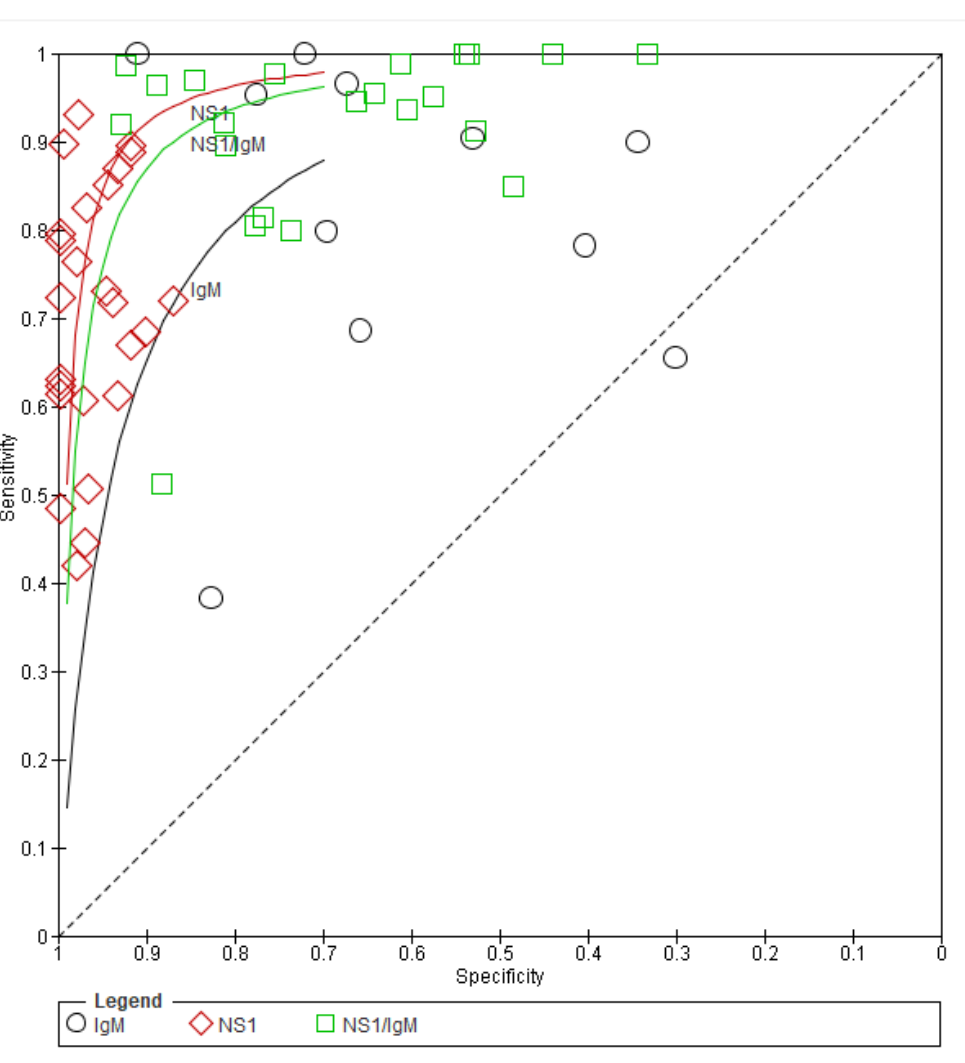
Figure 5. Summary ROC plot of tests: (1) IgM, (2) NS1, (3) NS1/IgM.